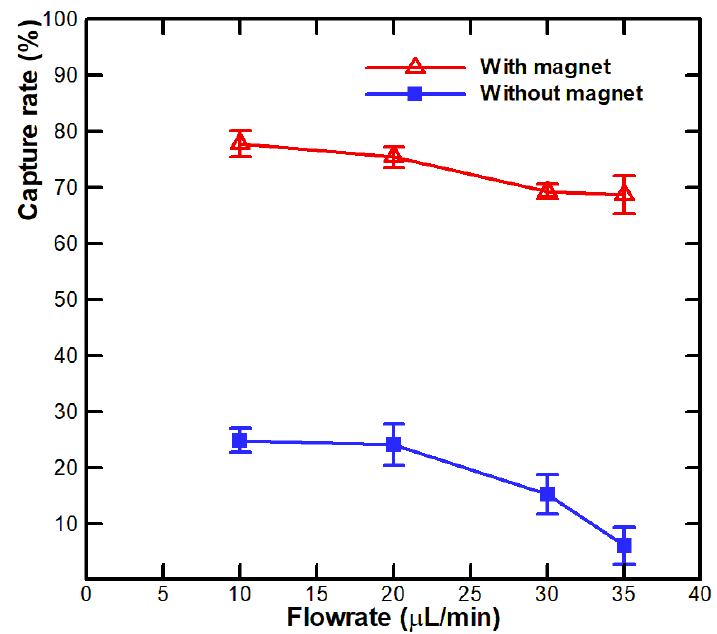
Figure 6. Isolation results of the A549 cells at different flow rates.